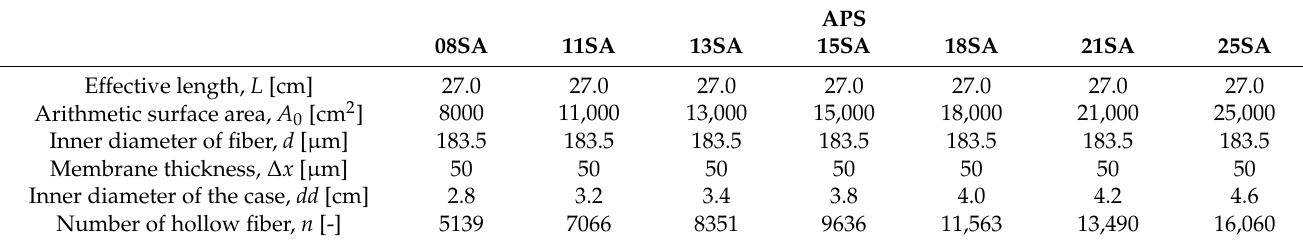
Table 1. Technical specifications of APS-SA series.